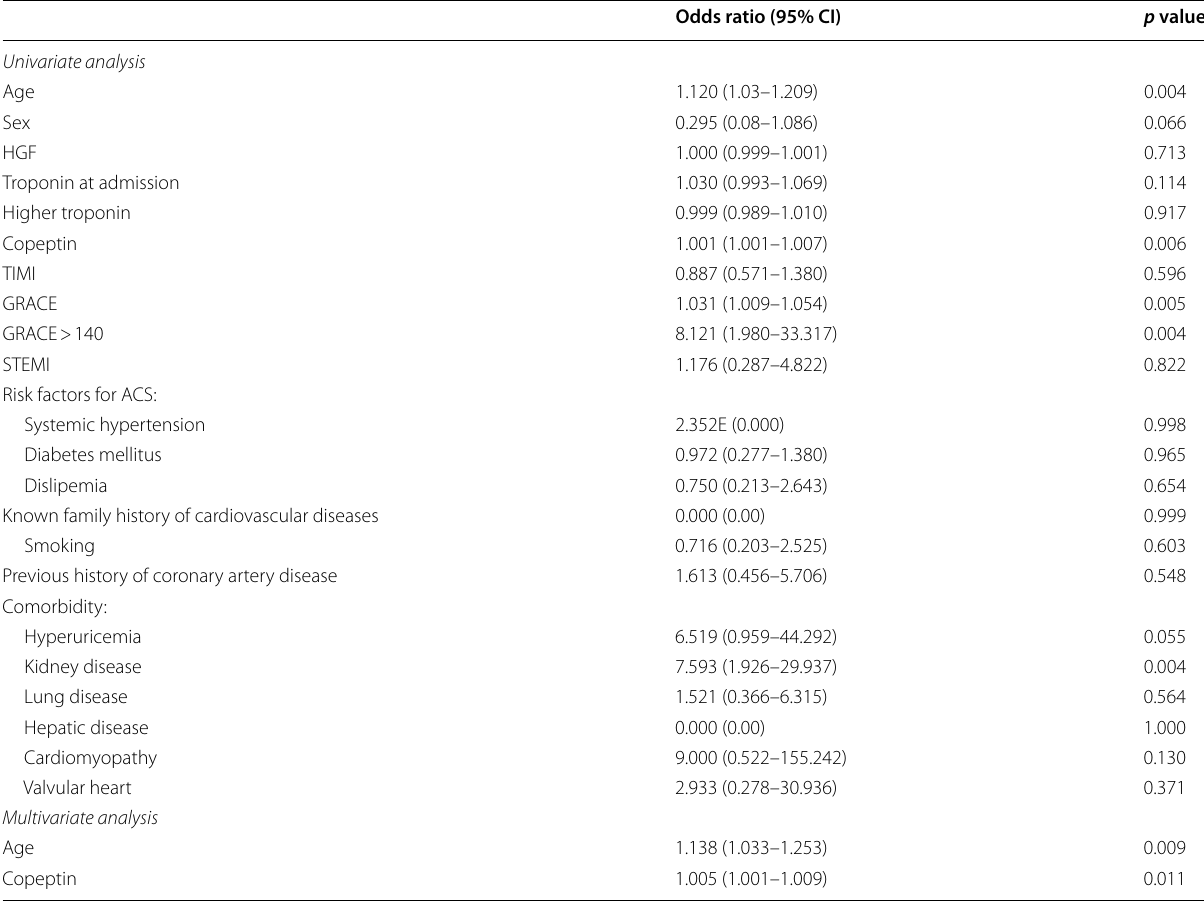
Table 3 Factors associated to hospital